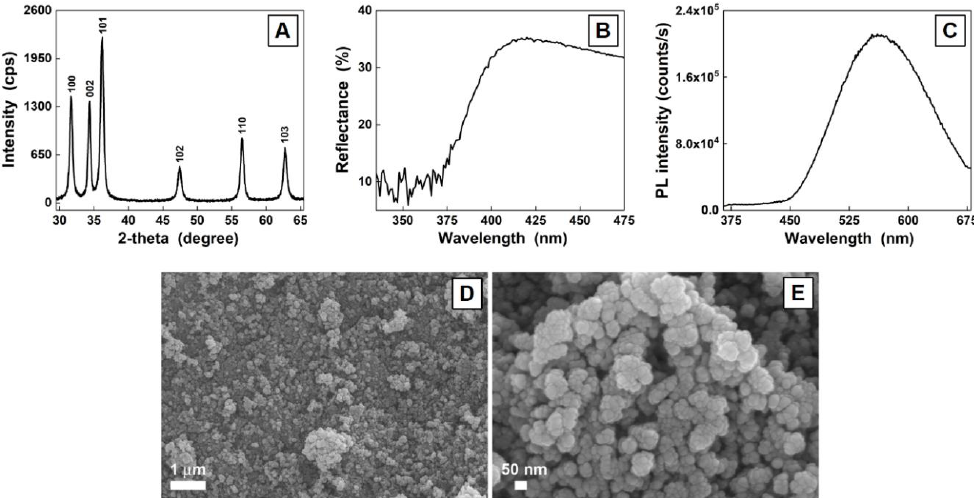
Figure 1. X-ray diffraction (XRD) pattern ( A ), reflectance (R) spectrum ( B ), photoluminescence (PL) spectrum ( C ) and field-emission scanning electron microscopy (FESEM) images ( D , E ) of the ZnO nanoparticles synthesized by precipitation.